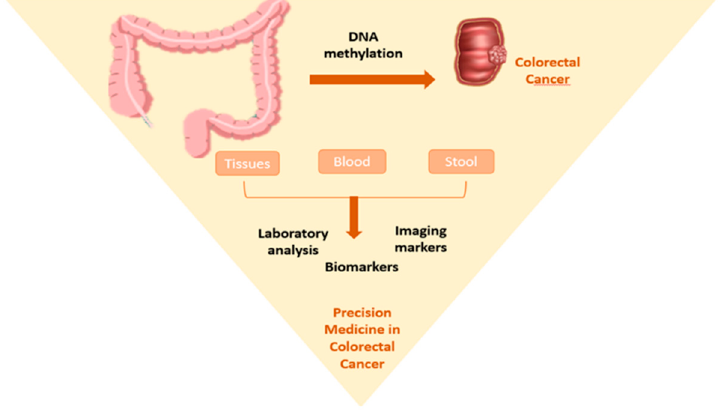
Figure 1. Emerging testing strategies in CRC based on methylated DNA biomarkers.